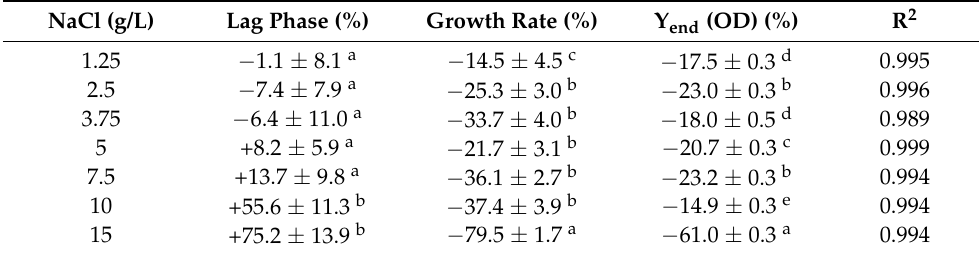
Table 2. Variations (%) in lag phase duration, growth rate and final OD reached (Y end ) of Z. mobilis UMB478 grown in liquid culture in presence of NaCl (1.25–15 g/L) respect to control culture (no NaCl). Mean and standard deviation of two replicates compound; different superscript letters within a column indicate significantly different samples ( p < 0.05). NaCl (g/L) Lag Phase (%)